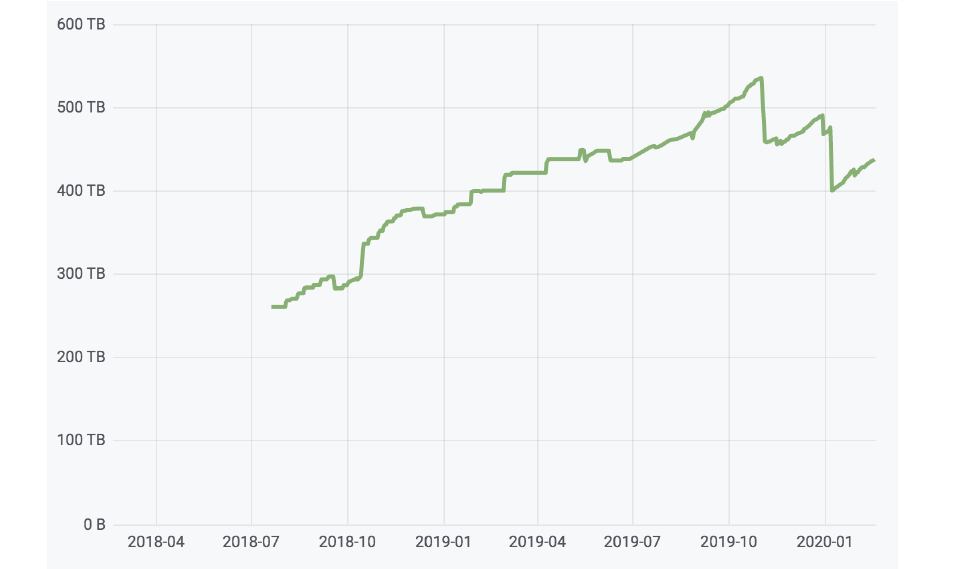
Figure 8. Growth of central storage utilization for the South Pole Telescope collaboration over the past 2 years. Due to limits on the capacity of the connect stash storage (Ceph), growth is caped and data purges are required to allow for processing of more recent data from the Pole.